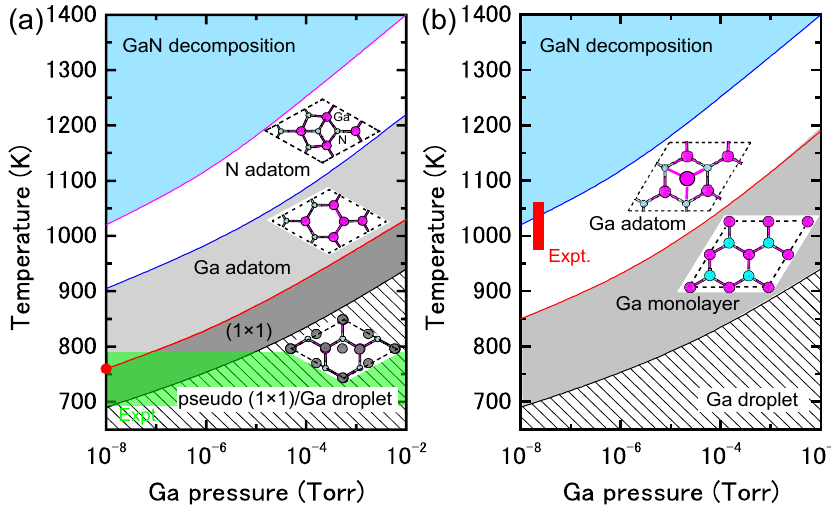
Figure 10. Calculated phase diagrams for polar GaN surfaces with ( a ) (0001) and _ ) orientations as a function of temperature and Ga beam equivalent pressure ( b ) (0001 (BEP). The stable reconstructions on these surfaces are also schematically presented. The shaded area denotes the molecular beam epitaxy (MBE) growth temperature range from Reference